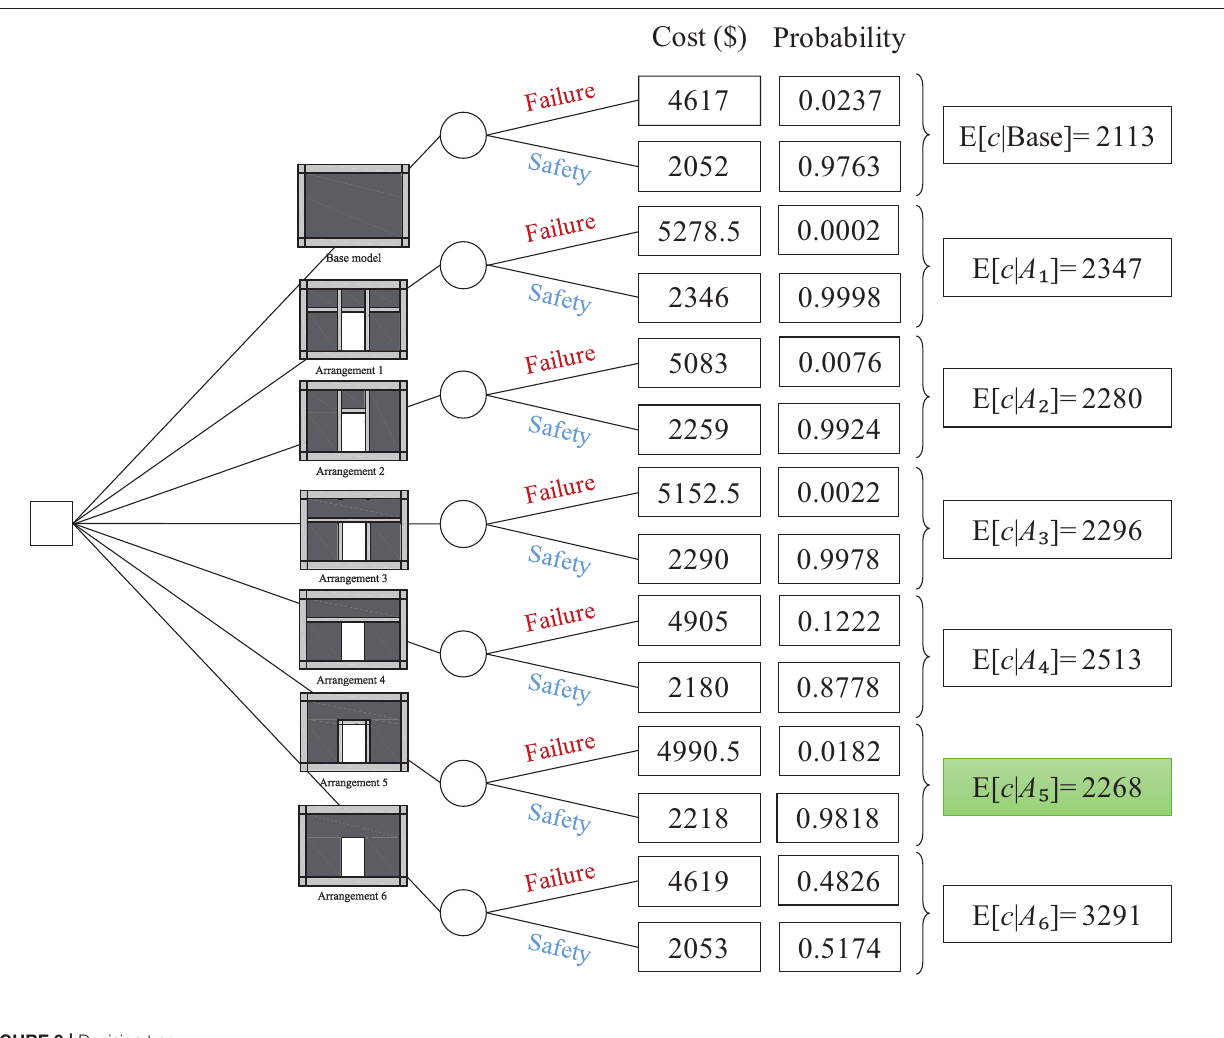
FIGURE 9 | Decision tree.